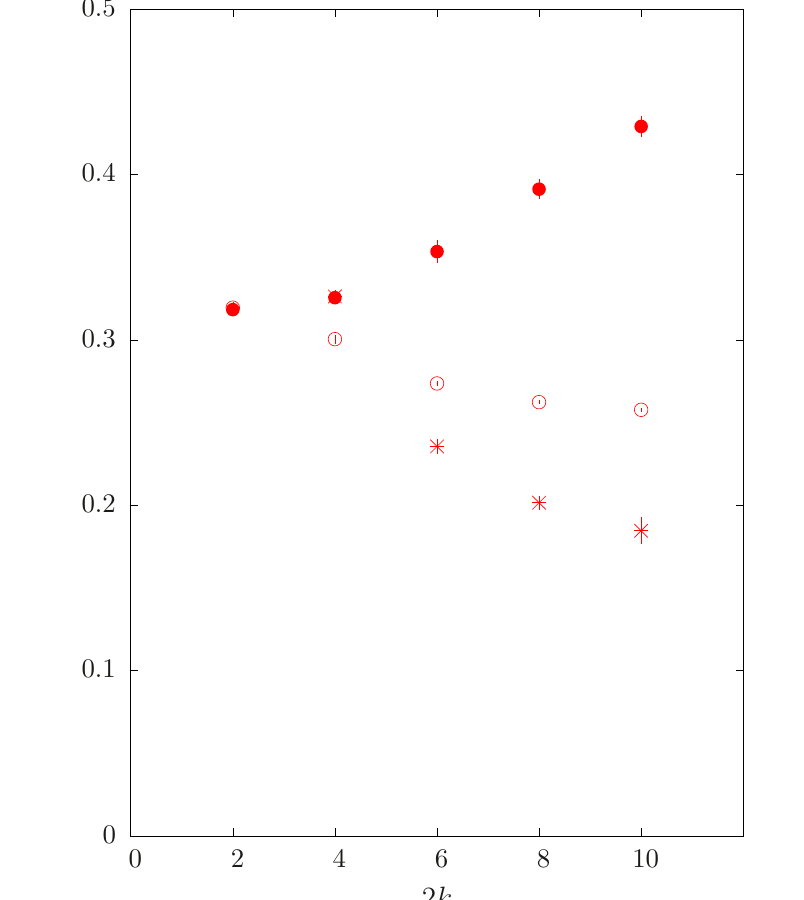
Figure 11 . String tensions in SO(2 k ) from the traces, units of the mass gap. Also the Pfa(cid:14)an string tension in units of the lightest Pfa(cid:14)an glueball, ?